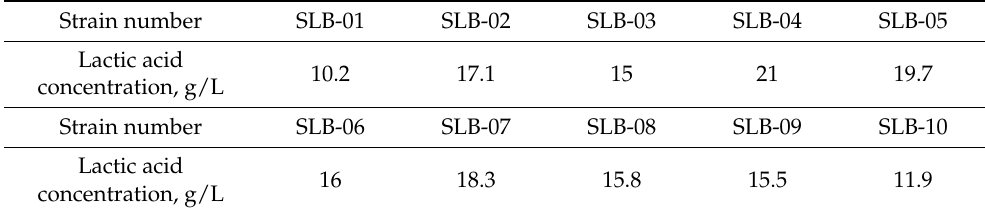
Table 4. The data for the lactic acid production of strains at the